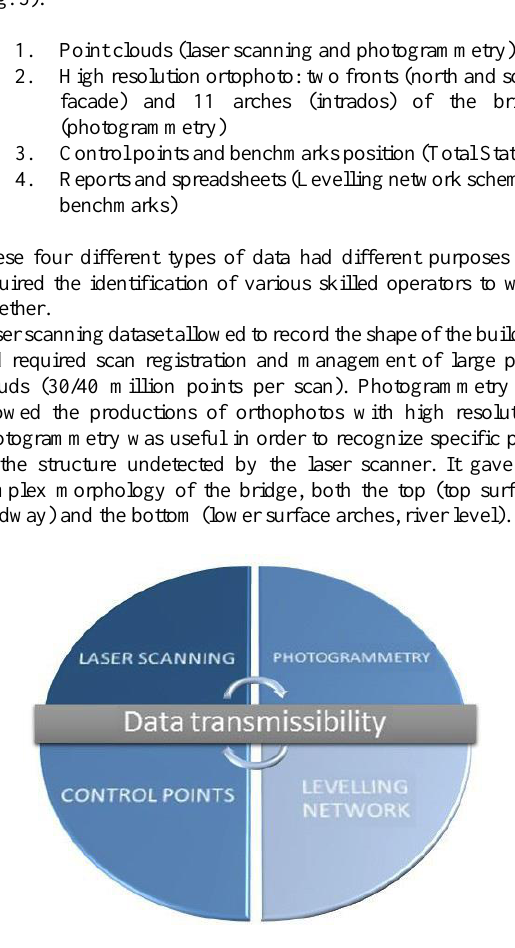
Figure 5. Data transmissibility into